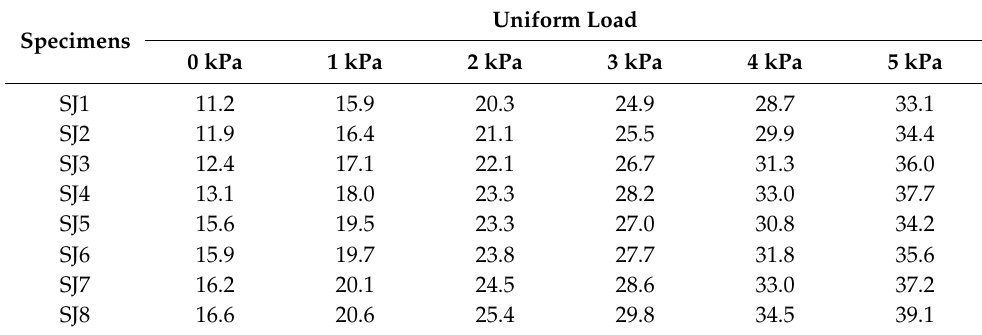
Figure 7. Coupling stress nephograms of SJ4 in the uniform load tests (MPa). ( a ) Uniform load is 1 kPa; ( b ) Uniform load is 3 kPa; ( c ) Uniform load is 5 kPa. Table 3. The coupling stress of testing point S22 (MPa).